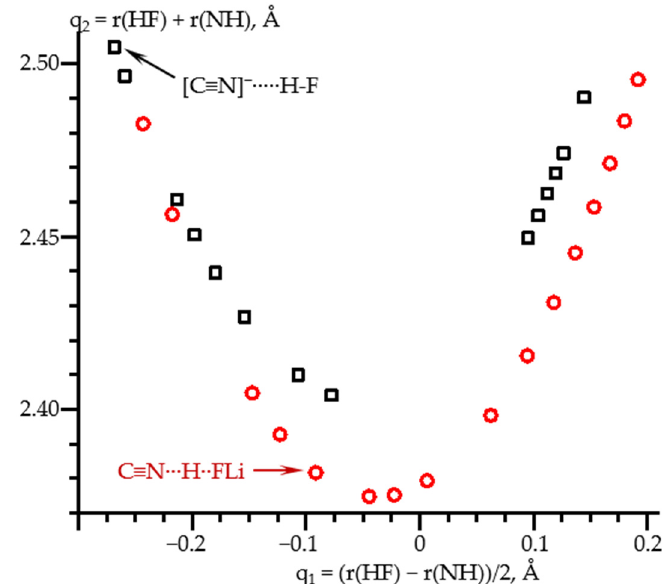
Figure 4. Hydrogen bond correlation q 2 vs. q 1 of the calculated equilibrium geometries of C ≡ N-H . . . F − (black squares) and C ≡ N-H . . . FLi (red circles) complexes at PCM = water and the effect of the external electric field. q 2 = r(HF) + r(NH) and q 1 = (r(HF) − r(NH))/2. The equilib- rium geometries in the absence of the field are shown by